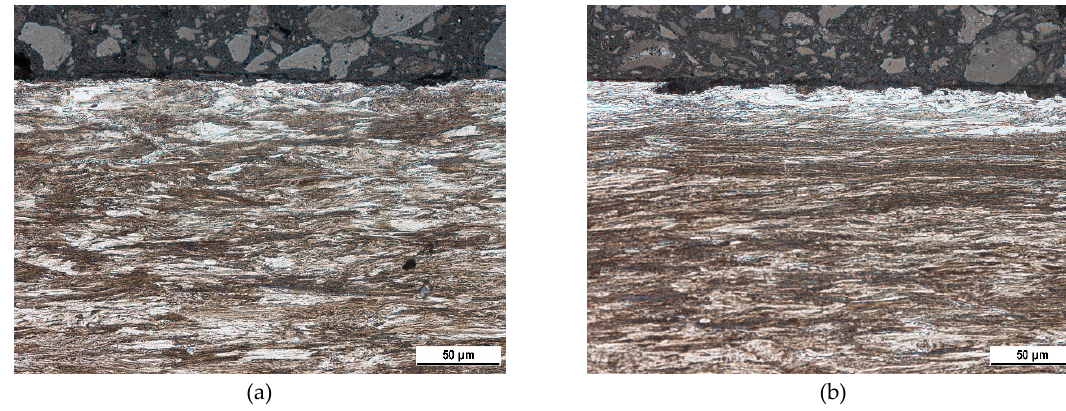
Figure 2. Metallographic images of wire n.2’s longitudinal direction. ( a ) Region 1; ( b ) region 2.